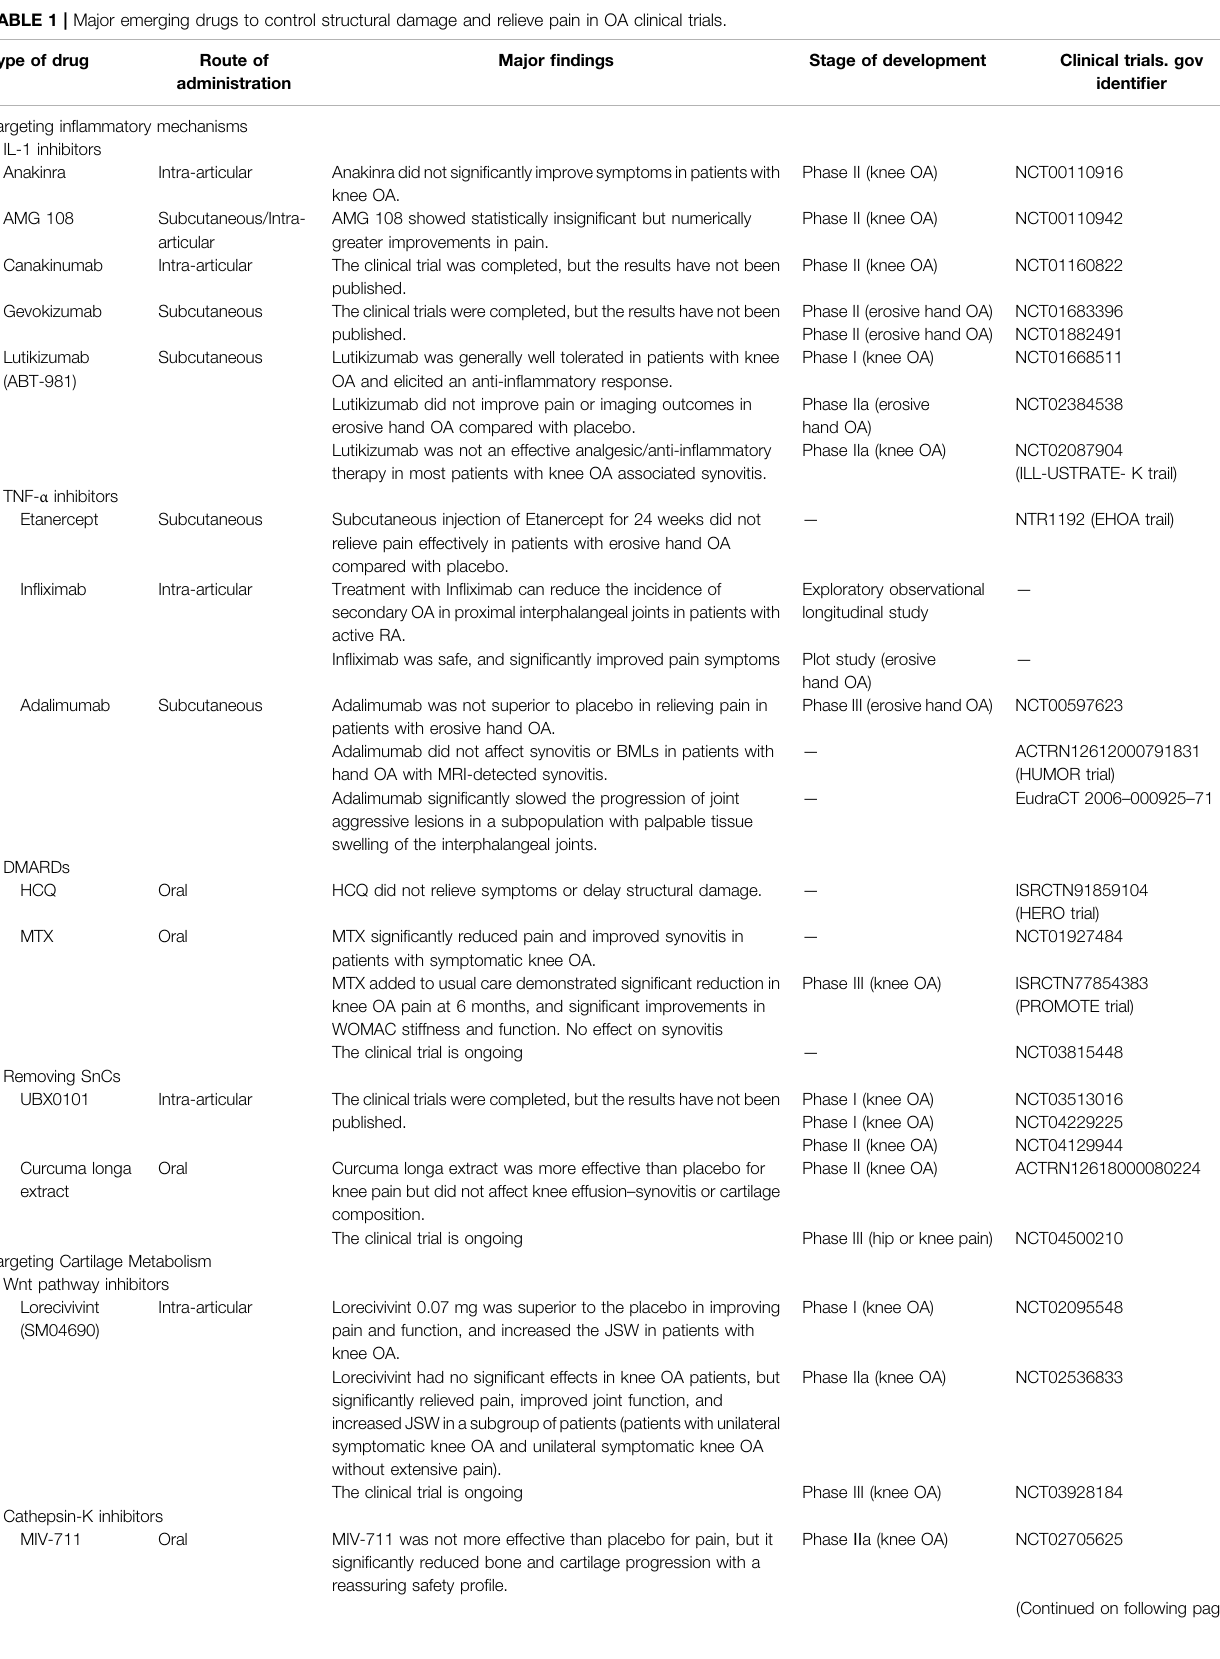
TABLE 1 | Major emerging drugs to control structural damage and relieve pain in OA clinical